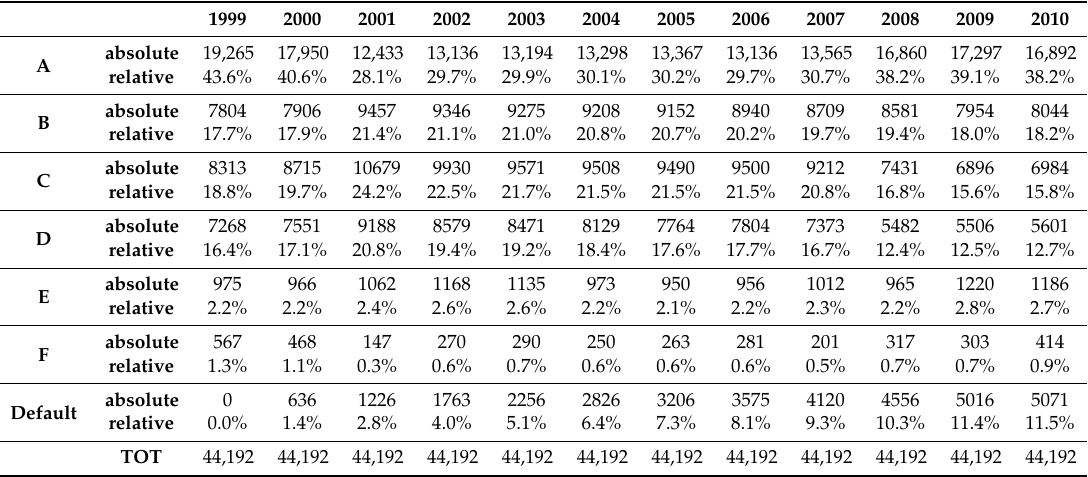
Table 1. Companies’ distribution. Absolute and relative values by year (1999–2010) and by rating classes. Rating classes range from A (lowest probability of default, PDs) to F (highest PDs). To maintain the total number of firms, equal each year we cumulate defaults which appear to increase over time. By “default” we mean all the firms in legal